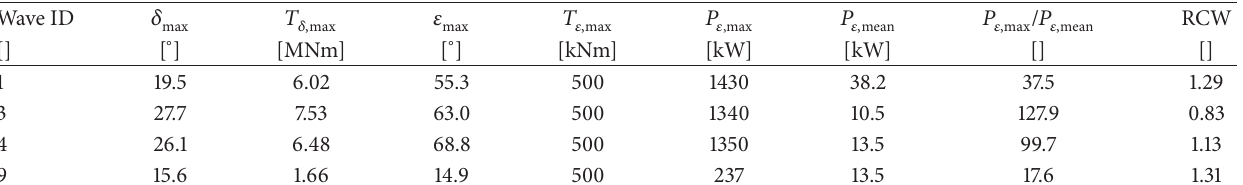
Table 5: Results with saturation on PTO torque at 500 kNm.